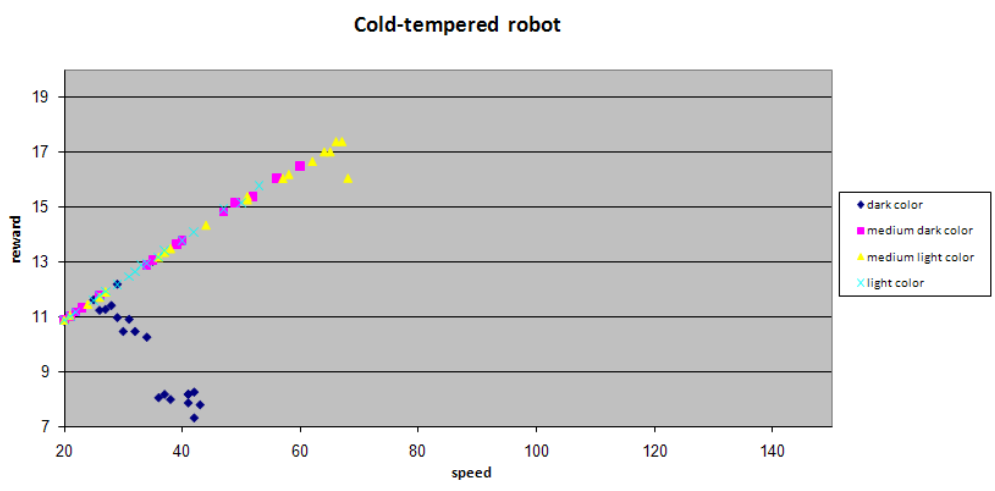
Figure 13. Performance of a cold-tempered robot against its speed.